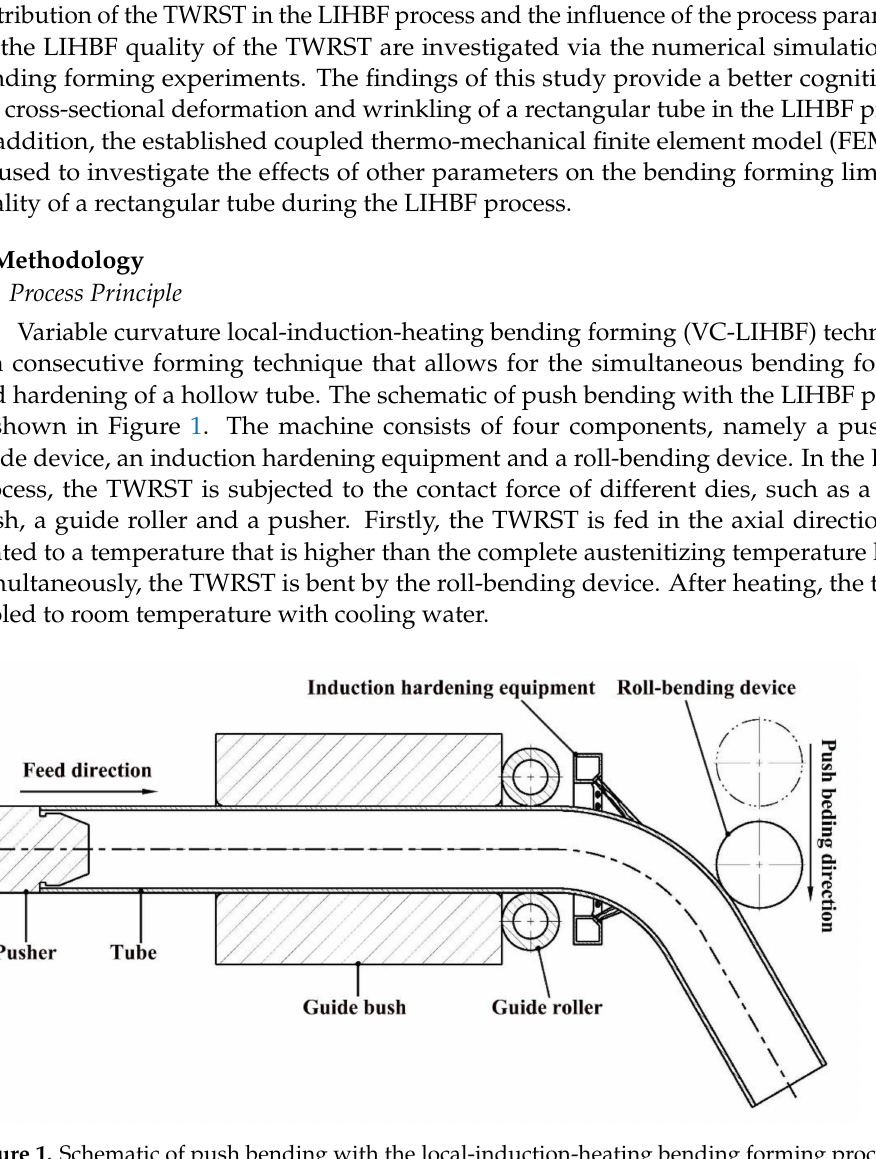
Figure 1. Schematic of push bending with the local-induction-heating bending forming